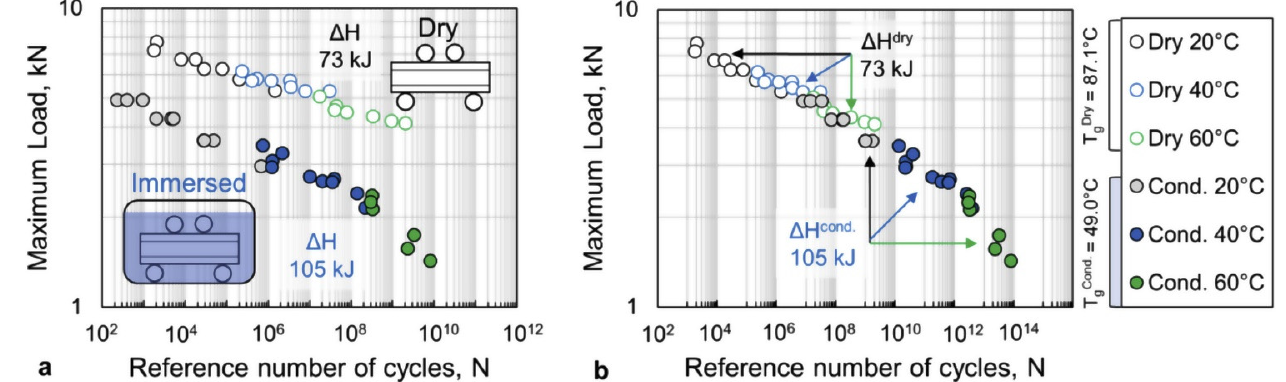
Figure 14. S–N master curves for dry and conditioned GFRP ( a ) and superimposed environmental master curve with the definition of equivalent temperature ( b ) [26].